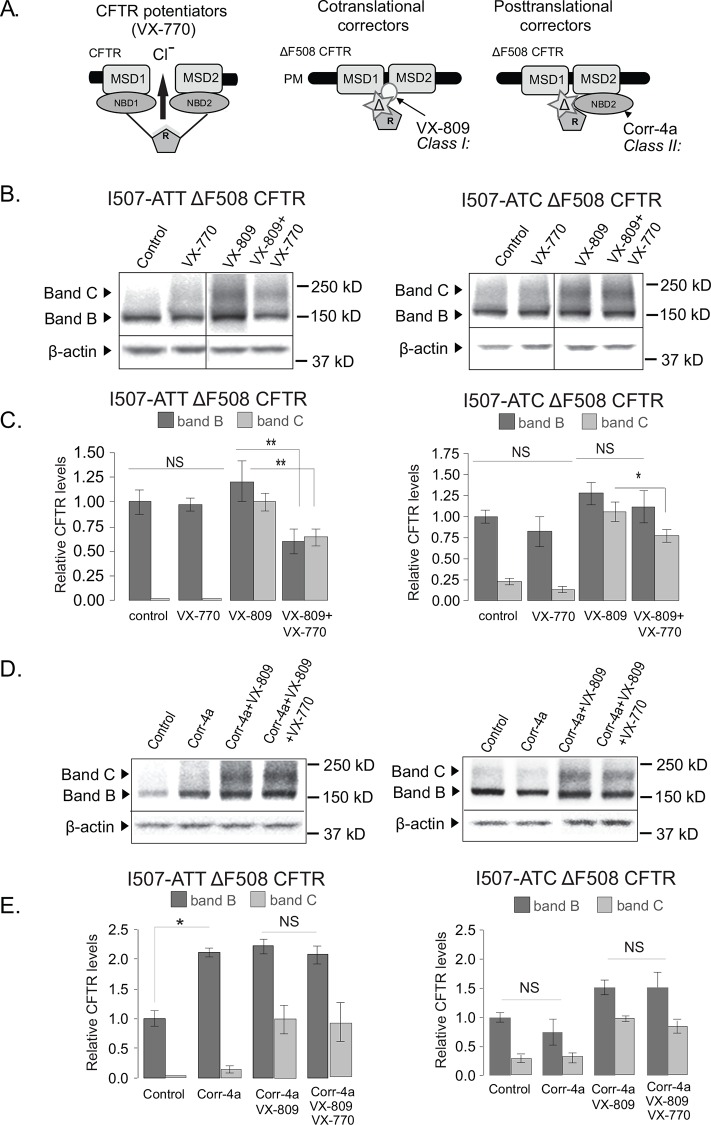
Corr-4a diminishes negative effects of VX-770 on VX-809-rescued I507-ATT ΔF508 CFTR.A. Mechanism of action of CFTR modulators used in our studies. B. Western blot analysis of I507-ATT and I507-ATC ΔF508 CFTR expressing HEK-293 cell lysates following vehicle control (0.15% DMSO, 16 h, 37°C) or corrector treatment (5μM VX-809, 5μM VX-770 and 5μM VX-809+5μM VX-770, 16 h, 37°C). Loading control: β-actin. C. Densitometry of band B and band C I507-ATT and I507-ATC ΔF508 CFTR levels. CFTR band B was plotted relative to vehicle control (DMSO). Band C was plotted relative to VX-809 (37°C). DMSO control, corrector VX-809 (VX-809), potentiator VX-770 (VX-770), combination (VX-809+VX-770), n = 9,9,6,3. D. Western blot analysis of I507-ATT and I507-ATC ΔF508 CFTR expressing HEK-293 cell lysates following vehicle control (0.2% DMSO, 24 h, 37°C), Corr-4a (10μM, 24 h, 37°C) or drug combination treatments (5μM VX-809+10 μM Corr-4a and 5μM VX-809+10 μM Corr-4a+5μM VX-770, 16 h, 37°C). Loading control: β-actin. E. Quantification of I507-ATT and I507-ATC ΔF508 CFTR levels. CFTR band B levels were plotted relative to vehicle control (DMSO). Band C levels were plotted relative to VX-809 (37°C). DMSO control (Ctr), corrector combination (VX-809+Corr-4a), combination of correctors and potentiator VX-770 (VX-809+Corr-4a+VX-770), n = 4. All values are means ± 1 SD. *p<0.05; **: p<0.02, significantly different from VX-809-treated sample by ANOVA, Turkey-Kramer procedure.